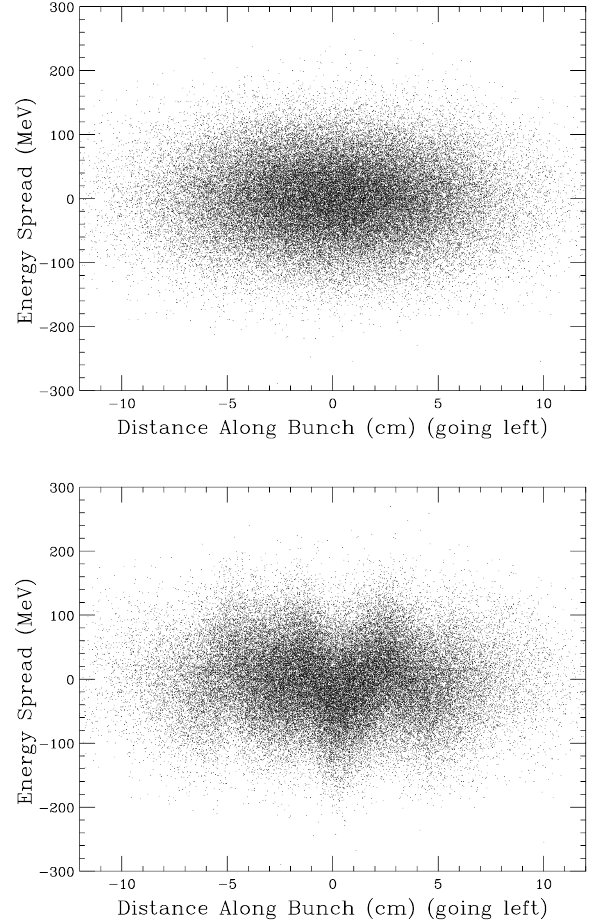
FIG. 2. Simulation of the 4-cm bunch of 4 3 10 12 muons subject to a broadband impedance with quality factor Q (cid:1) 1 and Z k (cid:1) n (cid:1) 0.5 V at the resonant angular frequency v r (cid:1) 50 GHz. The half-triangular bin width is 15 ps (0.45 cm) and 2 3 10 6 macroparticles are used. The top plot shows initial distribution with s E (cid:1) 60 MeV and s (cid:1) (cid:1) 4 cm. The lower plot shows distribution after 1000 turns with compensating rf’s initially at v 1 (cid:1)(cid:2) 2 p (cid:3) (cid:1) 1.290 GHz and v 2 (cid:1) 2 p (cid:1) 2.673 GHz, voltages V 1 (cid:1) 717.4 kV and V 2 (cid:1) 253.4 kV, and phases w 1 (cid:1) 170.55 ± and w 2 (cid:1) 159.33 ± . The rf voltages decrease according to the decay of the muons.